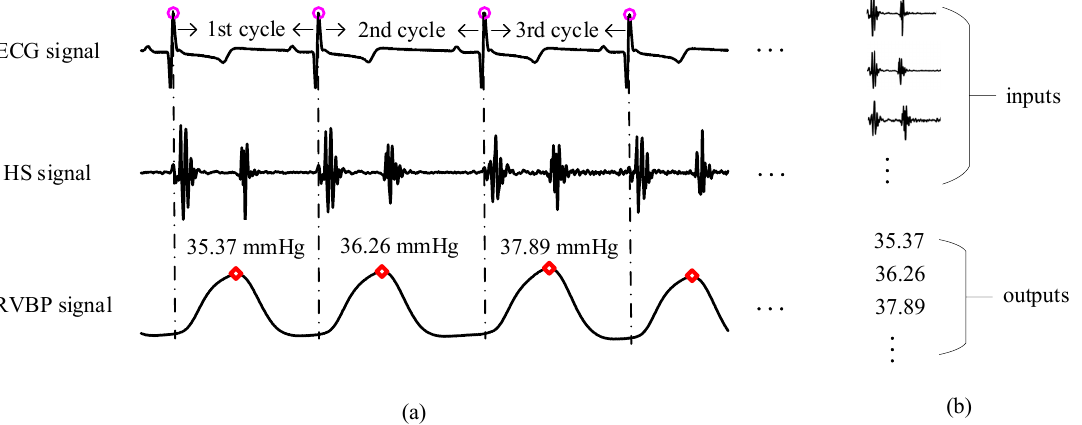
Figure 3. Constructed the inputs and outputs of the model; ( a ) segmentation of heart sound signal based on the R-wave positions. The pink circles indicated R-waves. The red diamonds indicated right ventricular systolic blood pressure (RVSBP) values; ( b ) inputs and outputs to the model.